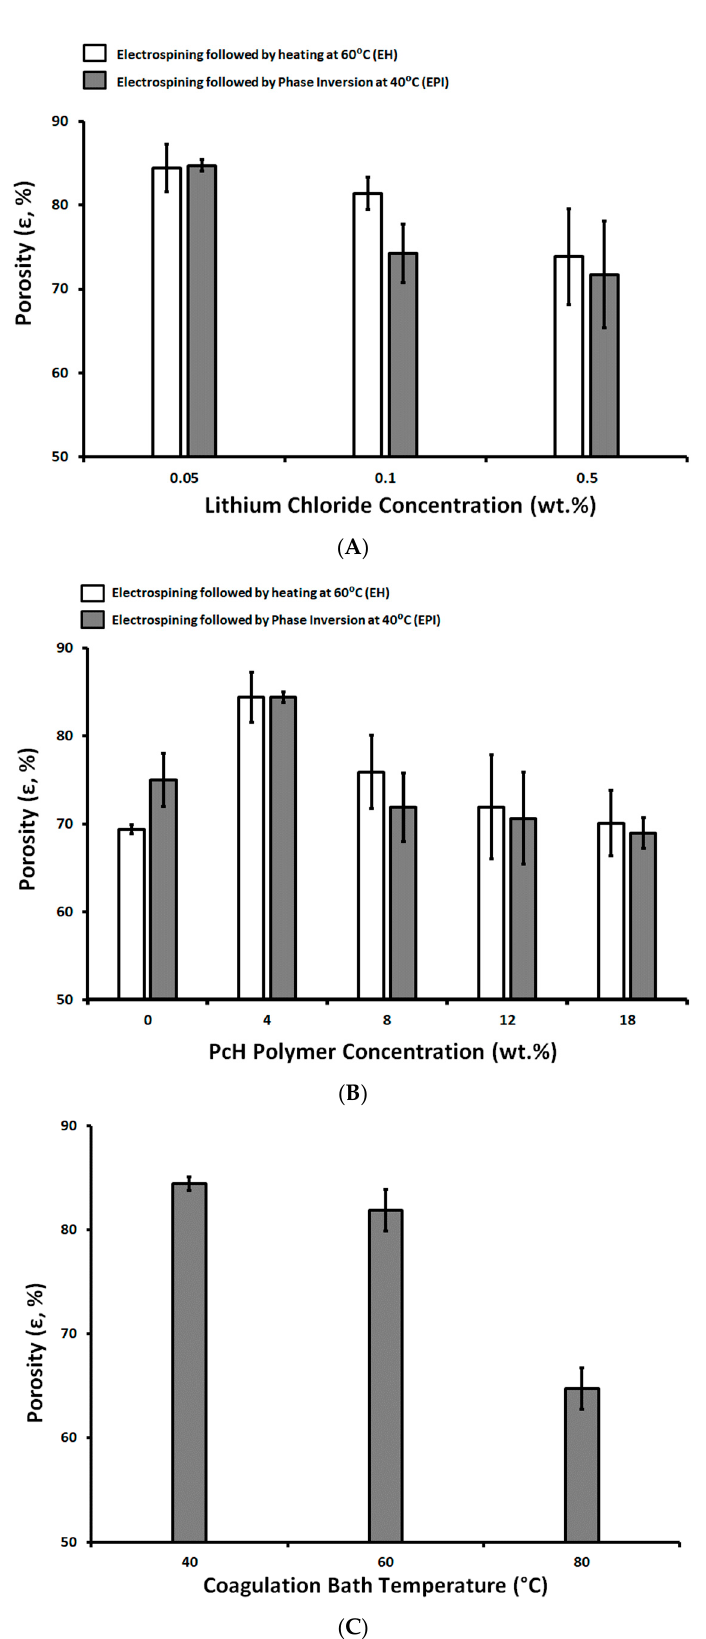
Figure 4. Membrane porosity as a function of Lithium chloride concentration (wt.%; A ), PcH polymer concentration (wt.%; B ), and coagulation bath temperature (°C; C ).